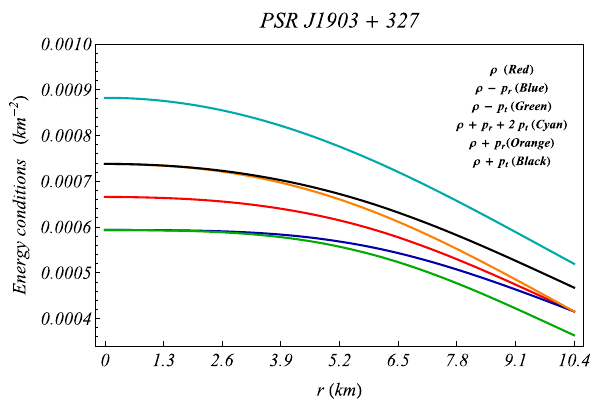
Fig. 4 Energyconditions areplottedagainst r insidethestellarinterior for the compact star PSR